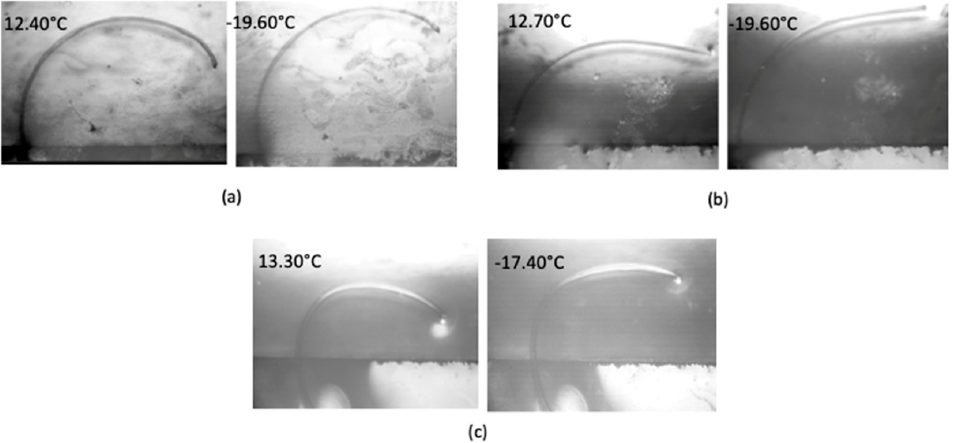
Figure 8 . Optical images of fiber curvature change at different temperatures. ( a – c ) display three different fiber samples with repeatable curvature change within the temperature range. Table 4. Predicted Curvature change based on bulk properties as a function of temperature change and fiber diameter.